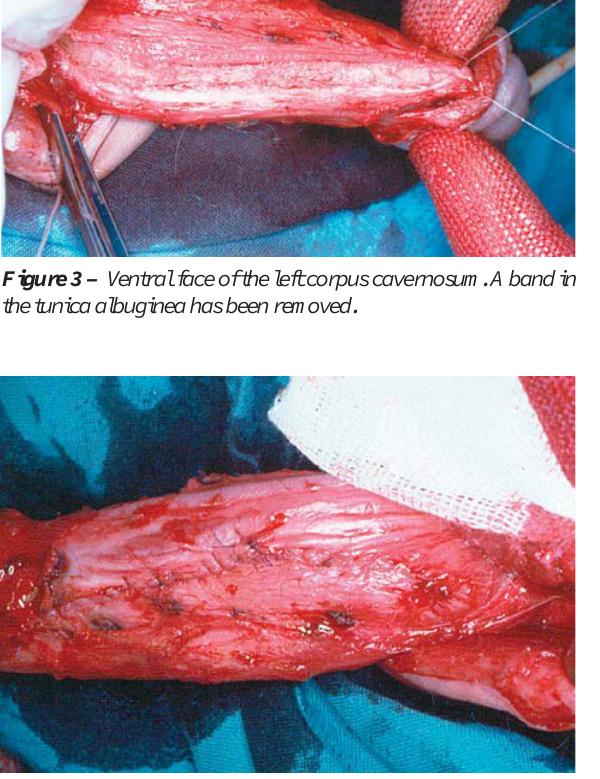
Figure 4 – Continuous suture by PDS 4-0 of the tunica albuginea on the ventral face of the left corpus